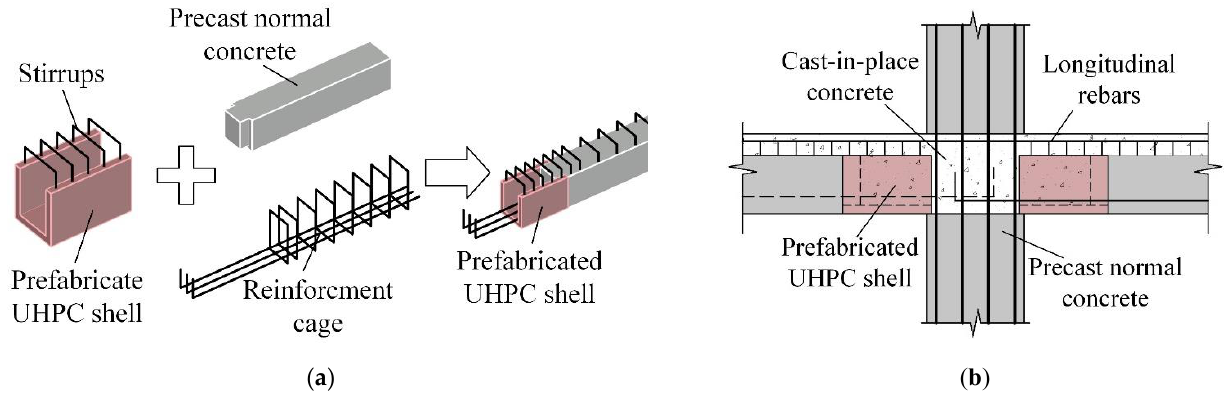
Figure 1. Schematic of the novel precast beam-to-column connection. ( a ) Precast beam, ( b ) connection.